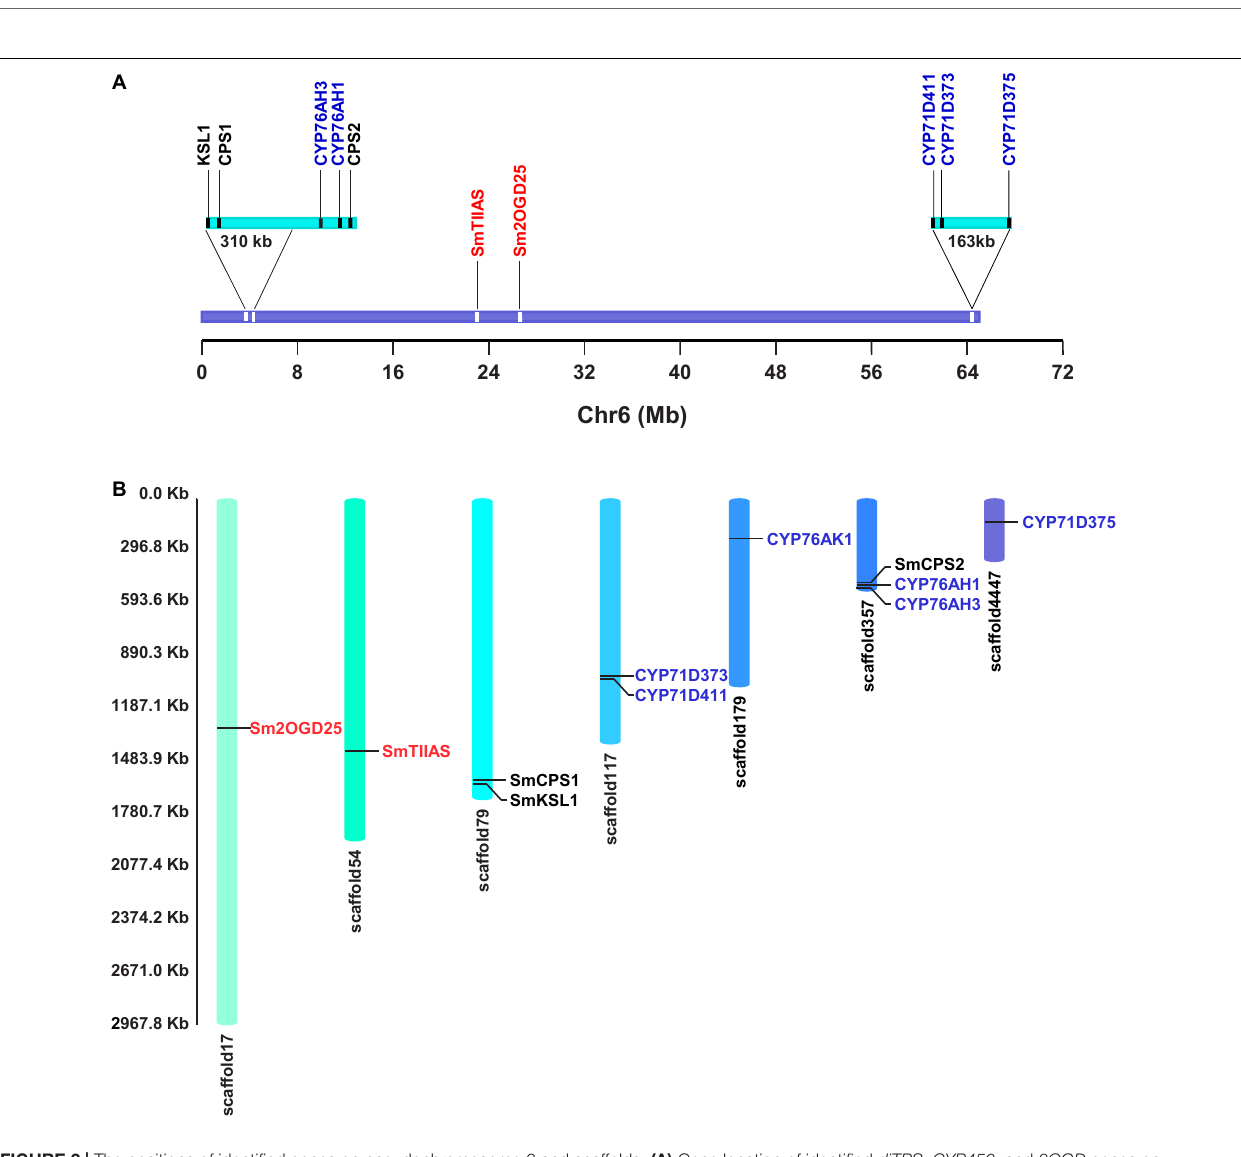
expression. After 20 h of incubation at 16 ◦ C, the cell pellets were collected by centrifugation (8,000 rpm for 5 min at 4 ◦ C), and resuspended in 50 ml lysis buffer (pH 7.5, 50 mM Tris– HCl, 300 mM NaCl), and broken up at 2–6 ◦ C by a cryogenic homogenizer. After centrifugation (12,000 rpm for 30 min at 4 ◦ C), the cell debris was removed and the crude enzyme was obtained. The supernatant was subsequently mixed with 2 ml Ni-NTA resin (TransGen Biotech, China) and incubated for 1 h in an ice bath. Then, the mixture was applied to an Affinity Chromatographic Column (TransGen Biotech, China), which was pre-equilibrated with lysis buffer. The target recombinant protein was eluted by elution buffer containing 100 mM imidazole. The purified protein was concentrated and desalted by a 30 kDa ultrafiltration tube (Solarbio, China) with storage buffer (pH 7.5, 50 mM Tris–HCl, 300 mM NaCl, 20%